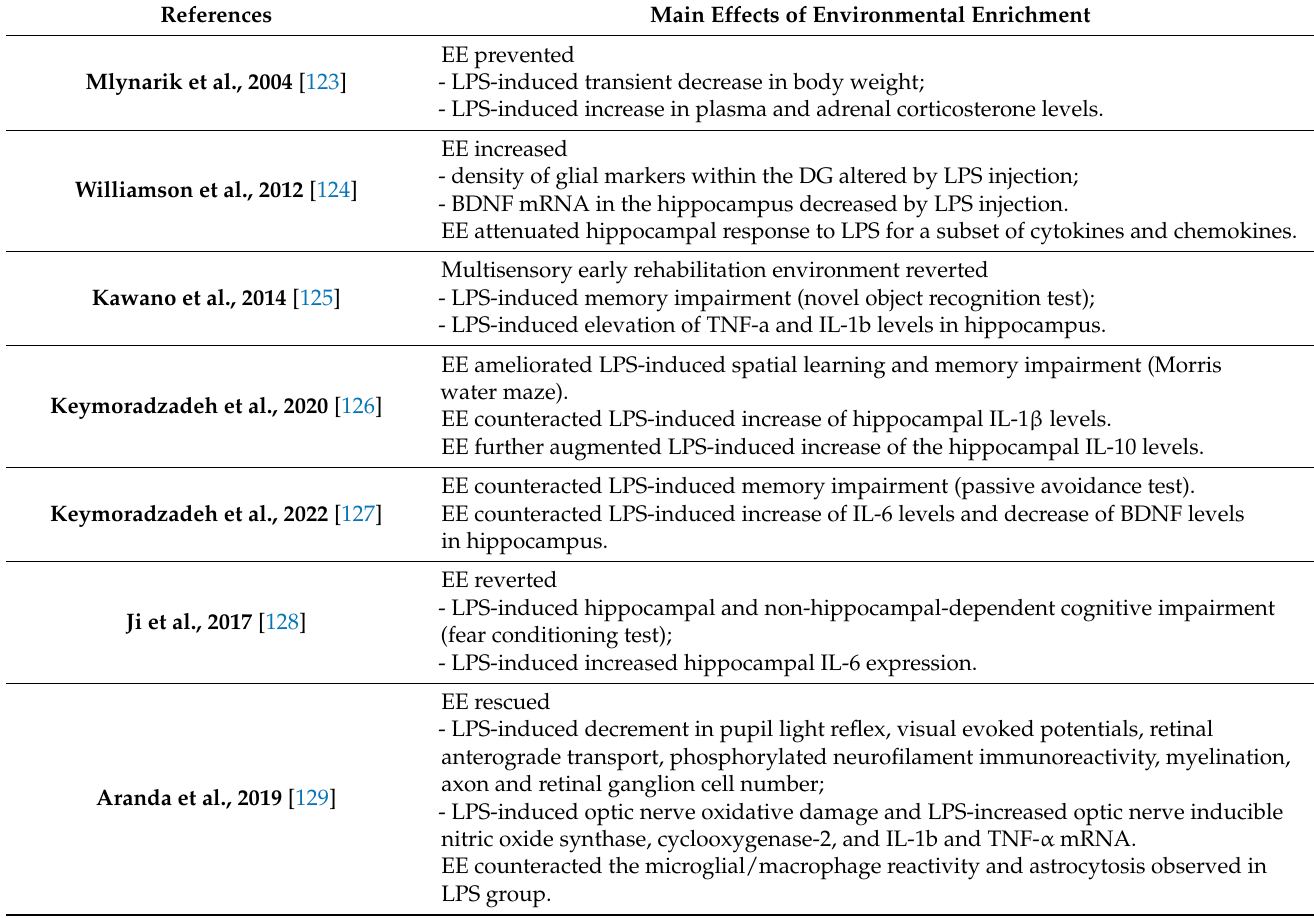
Table 6. Main effects of environmental enrichment in case of inflammation in